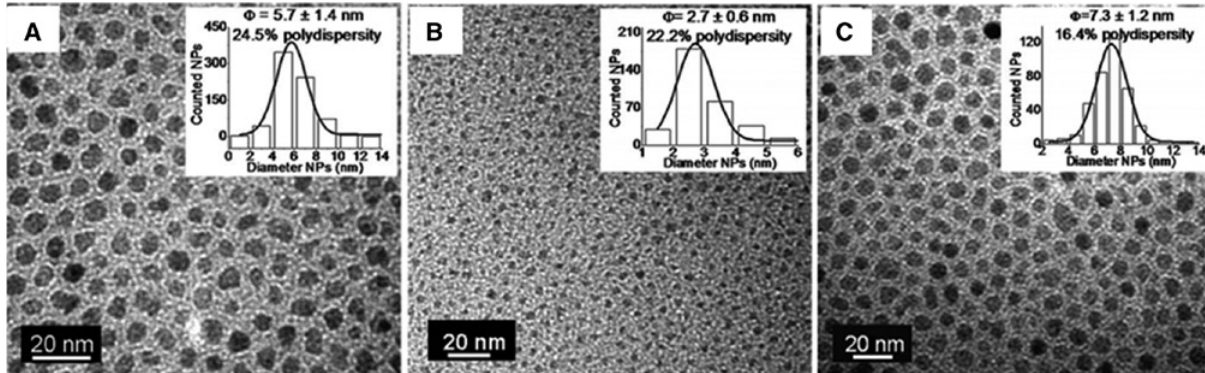
Figure 24: Superparamagentic ferrite NPs synthesized via supercritical ethanol route with in ( ex ) situ oleic acid (OAc) functionalization: (A) FeFe O @OAc NPs, (B) MnFe 2 4